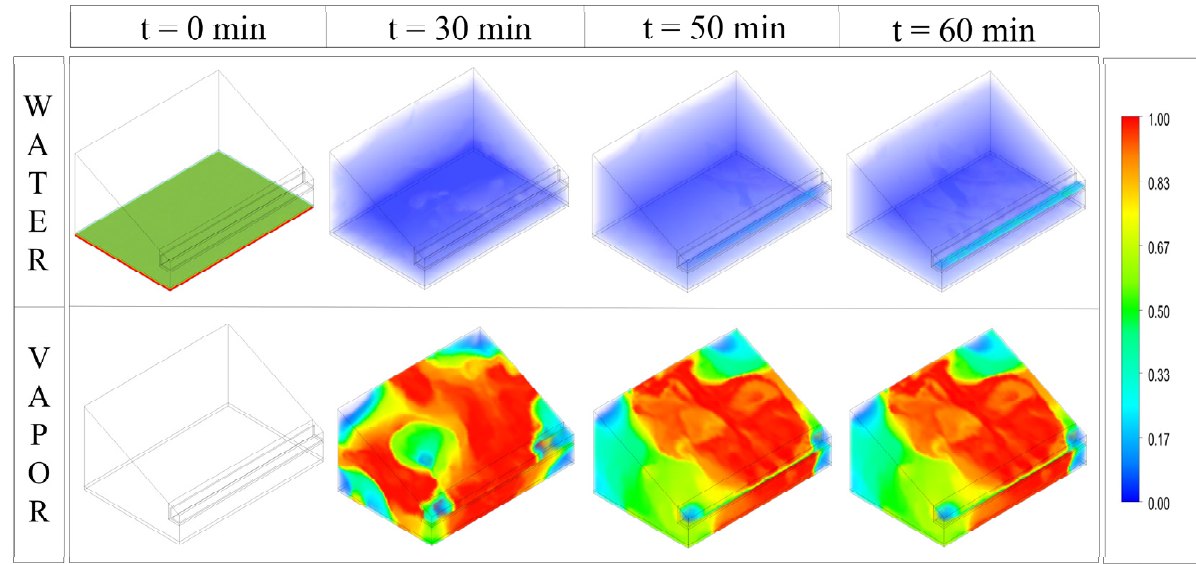
Figure 14. A volumetric fraction over time with volume rendering of water and vapor.